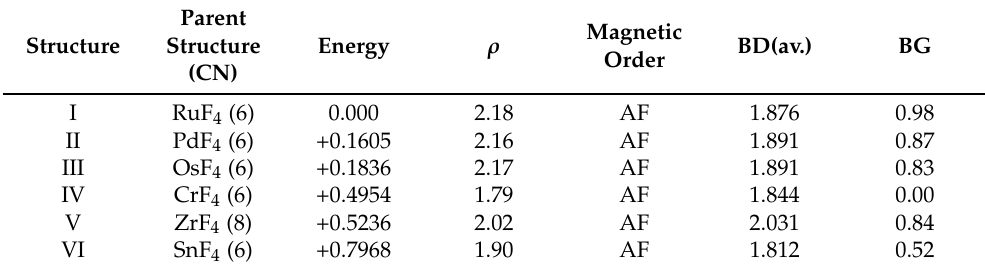
Table 2. Structure numbering, parent structure formulas with their coordination number (CN), energies per formula unit of the calculated NiF 4 structures relative to the most stable structure (I: RuF 4 ; in eV), densities of the calculated crystals (in a.u.), magnetic ordering within the crystals (AF: antiferromagnetic), average Ni − F bond distances of the first coordination sphere (in Å), labeled as BD(av.) and calculated band gaps, labeled as BG (in eV).